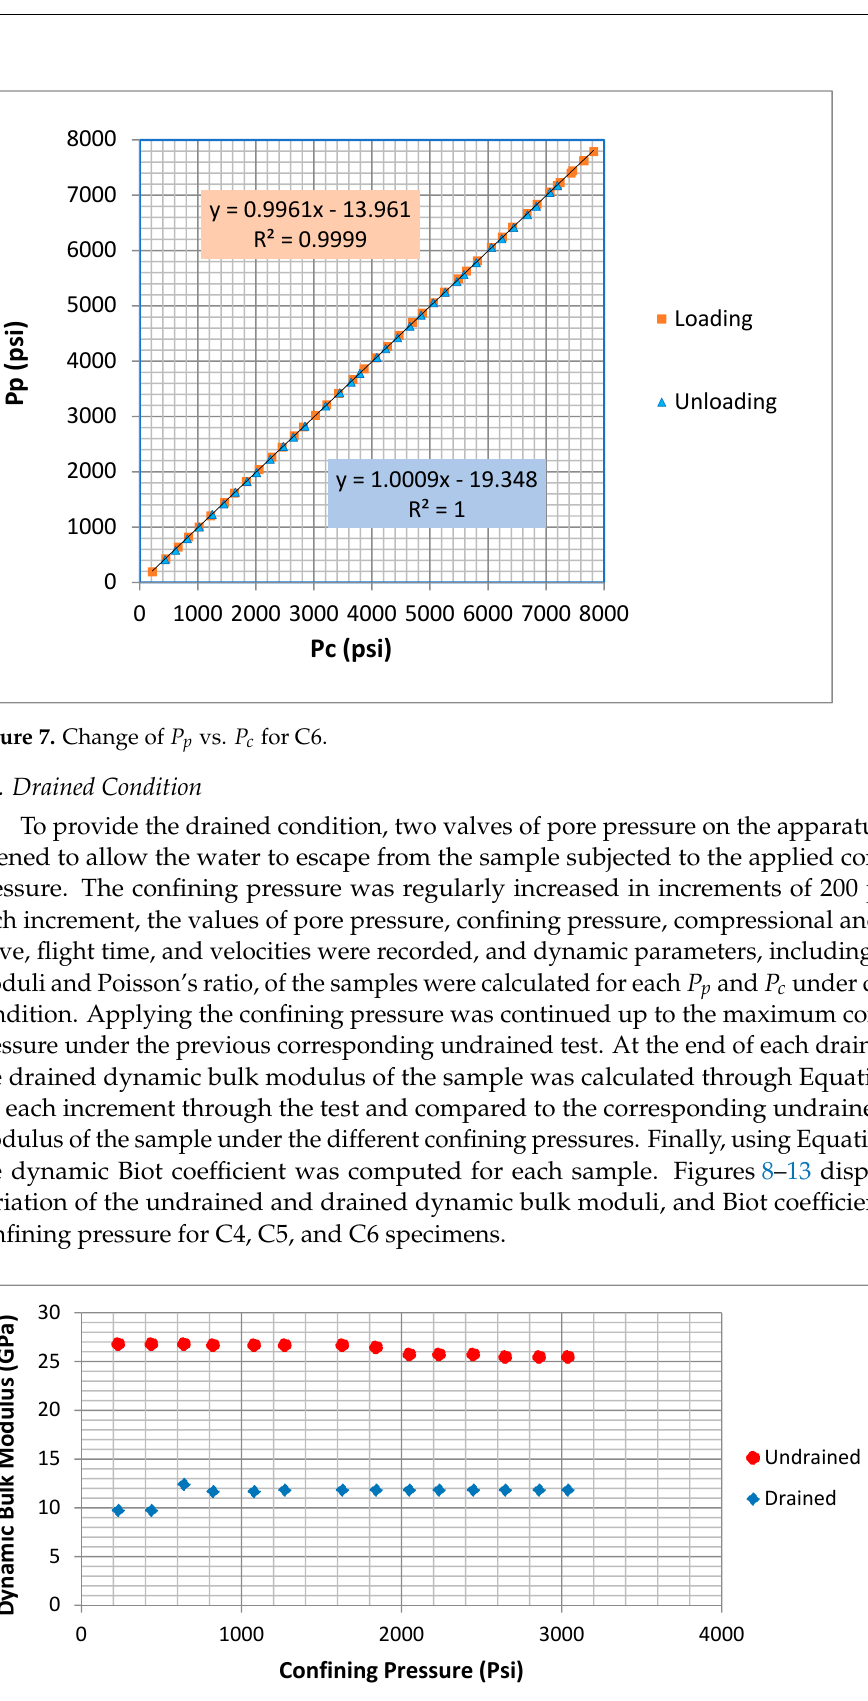
Figure 8. Undrained and drained dynamic bulk moduli vs. confining pressure for C4.